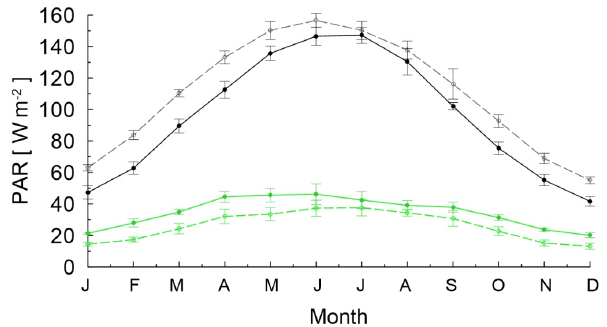
Figure 7. Global (black) and diffuse (green) monthly average PAR in all-sky (solid lines) and in cloud-free (dashed lines)